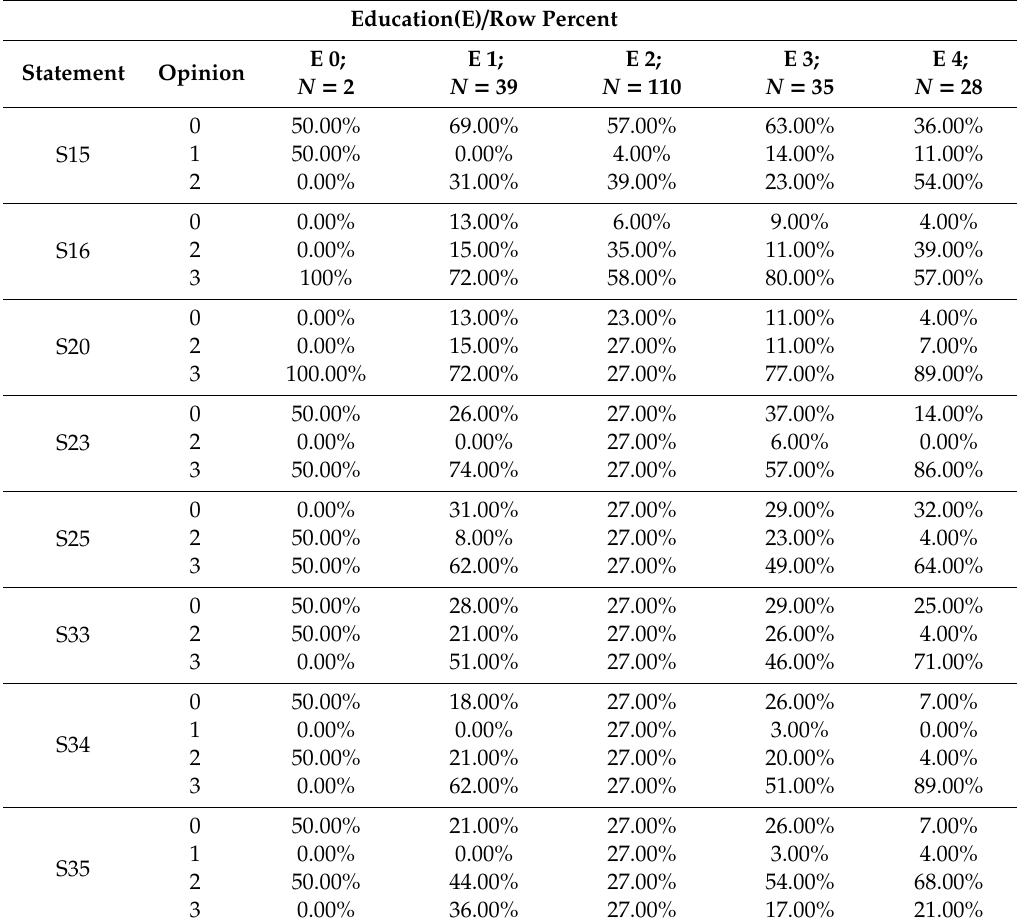
Table 4. Education as a factor significantly influencing opinions and attitudes to